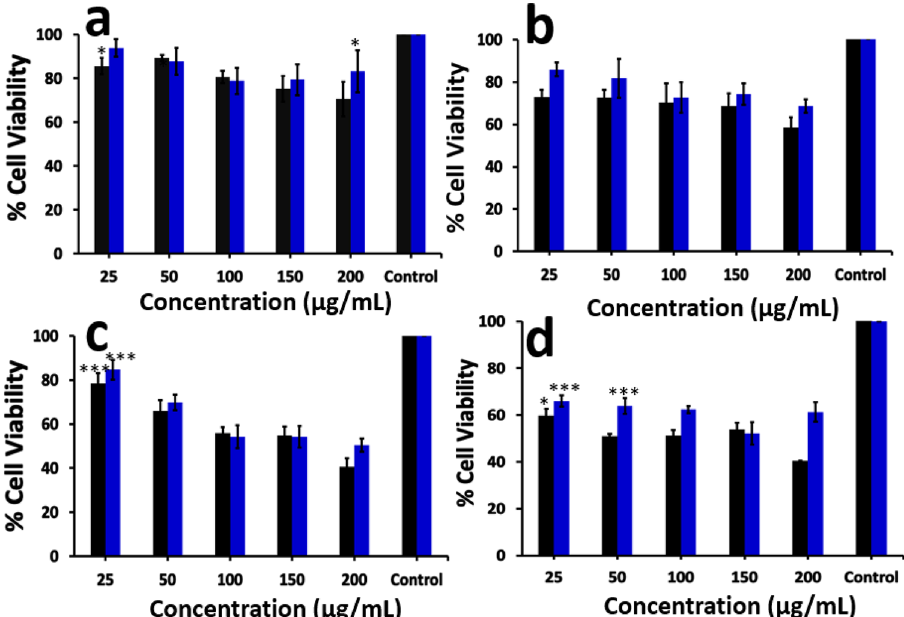
Figure 2. Cell viability of BHK-21 cells exposed to different concentrations of PVC ( ■ ) and PMMA ( ) NPs for 24 h ( a ), 48 h ( b ), 96 h ( c ), 120 h ( d ). The data for 72 h incubation is given in supporting information Figure S5. The results are expressed as % of the viability as compared to the control, mean ± SEM values of n = 3 independent experiments are given. Statistical analysis was done by one-way ANOVA (* p < 0.05, ** p < 0.01, *** p < 0.001, **** p < 0.0001) and compared to control cells with no NP exposure.